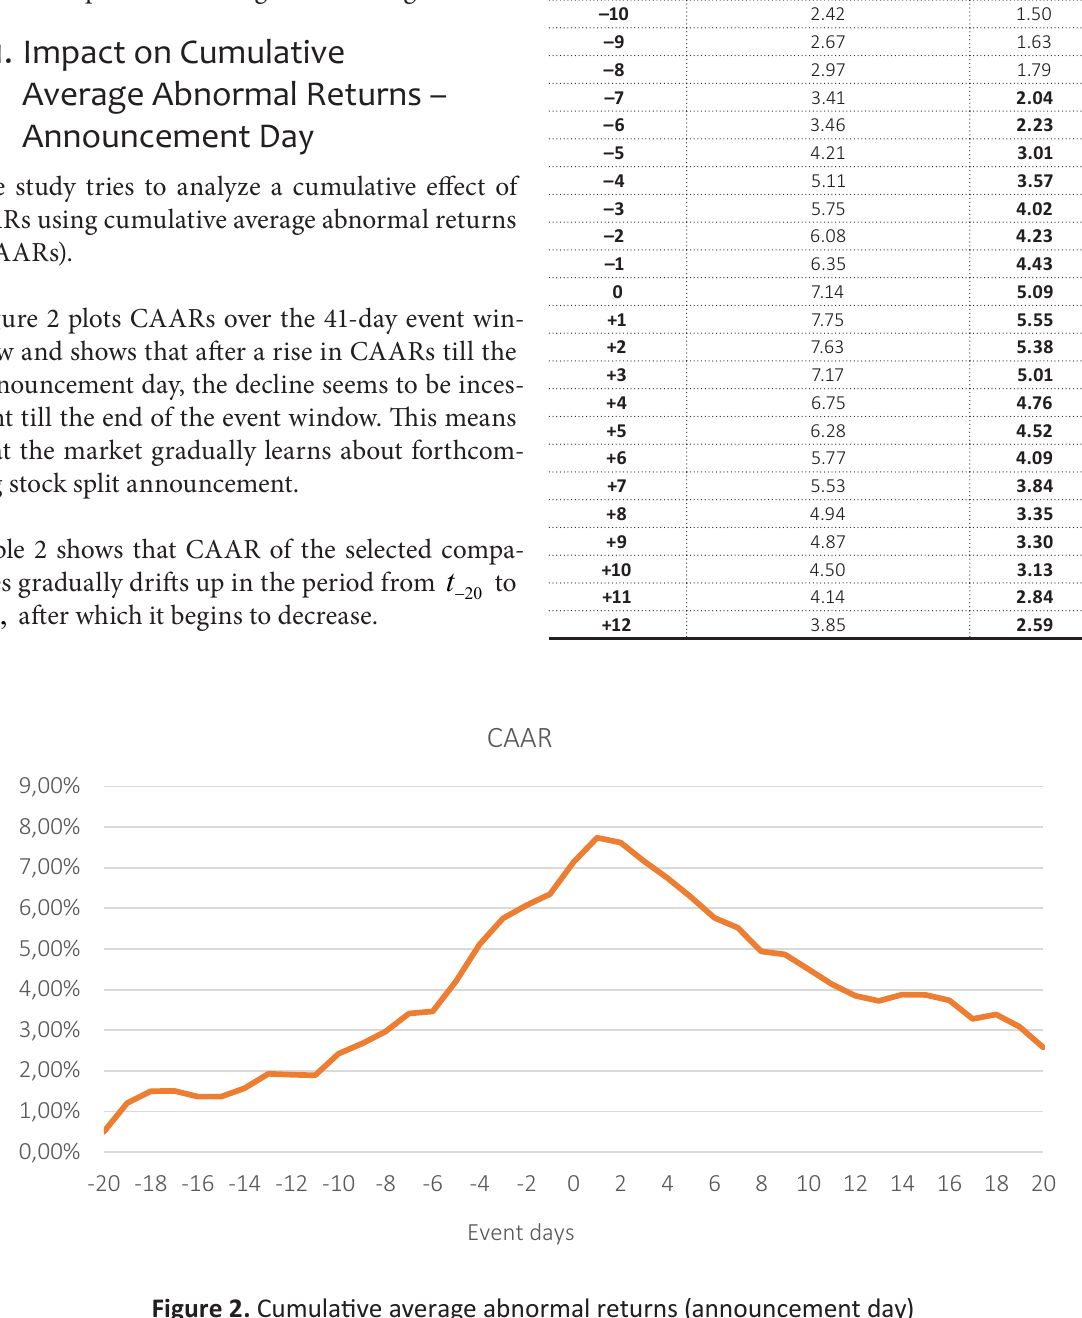
Figure 2. Cumulative average abnormal returns (announcement